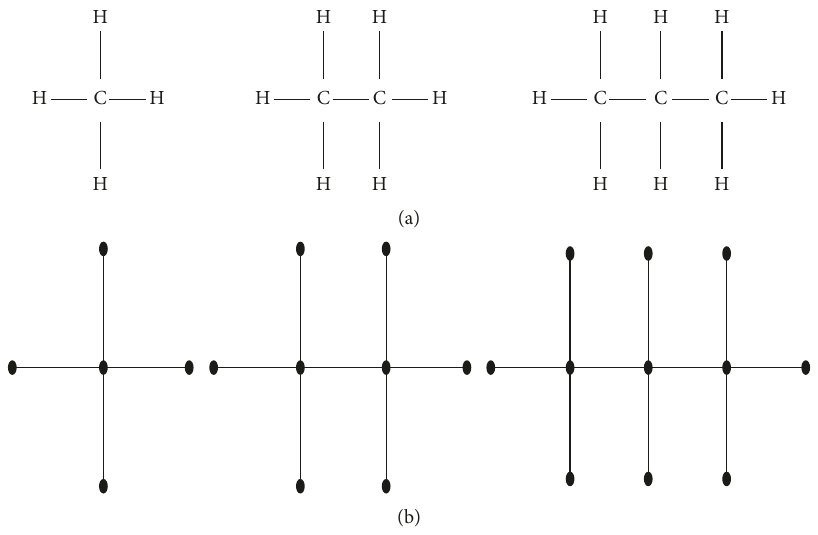
Figure 1: Alkanes (CH